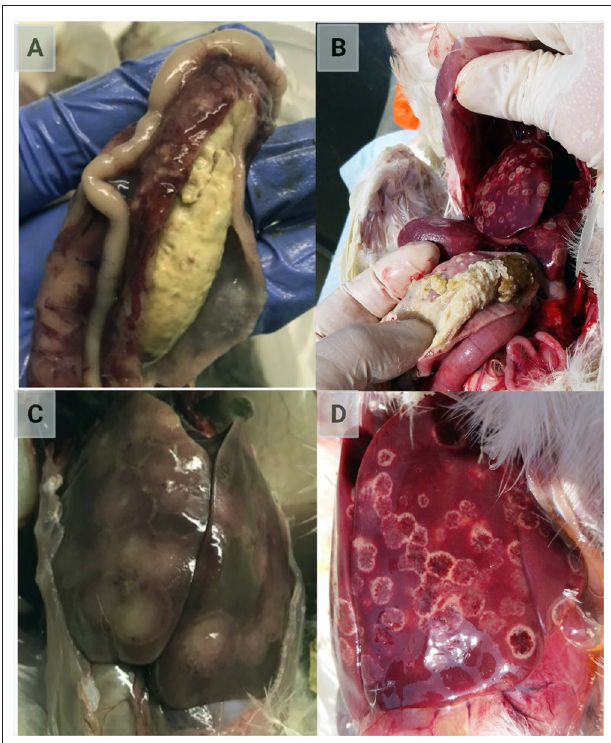
FIGURE 3 | Classic lesions resulting from Histomonas meleagridis infection. (A,B) Caseous cheese-like cecal core; (C,D) focal necrosis resulting in target-like liver lesions (Created with